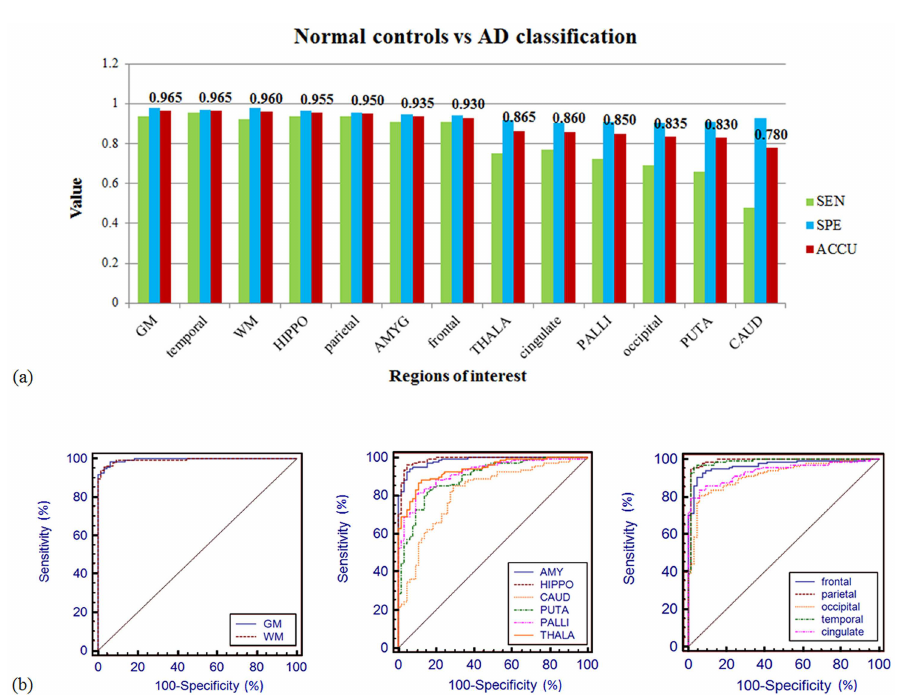
Fig 3. (a) Classification sensitivity (green), specificity (blue), and accuracy (red) of normal elderly controls versus AD patients with different ROIs. The highest accuracy(96.5%) was achievedusing the whole-brain gray matter as ROI with 93.85% sensitivity and 97.78% specificity. The algorithmobtainedhigh sensitivity and specificity ( > 90%)with half of the ROIs. (b) The ROC curve of the prediction accuracy betweennormal controls versus AD. The AUCs were larger than 0.98 for the whole-brain gray matter and white matter (left), amygdalaand hippocampus (middle), parietaland temporallobes